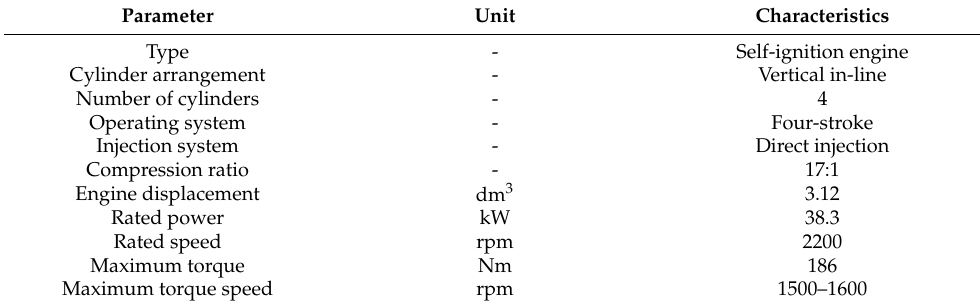
Figure 2. Scheme of the dynamometer stand: 1—test engine, 2—load brake, 3—shaft connecting the engine to the brake, 4—control and measurement system, 5—fuel consumption measuring system, 6—exhaust gas intake, 7—induction speed sensor, 8—exhaust gas temperature sensors. Table 3. Basic technical data of the S-4003